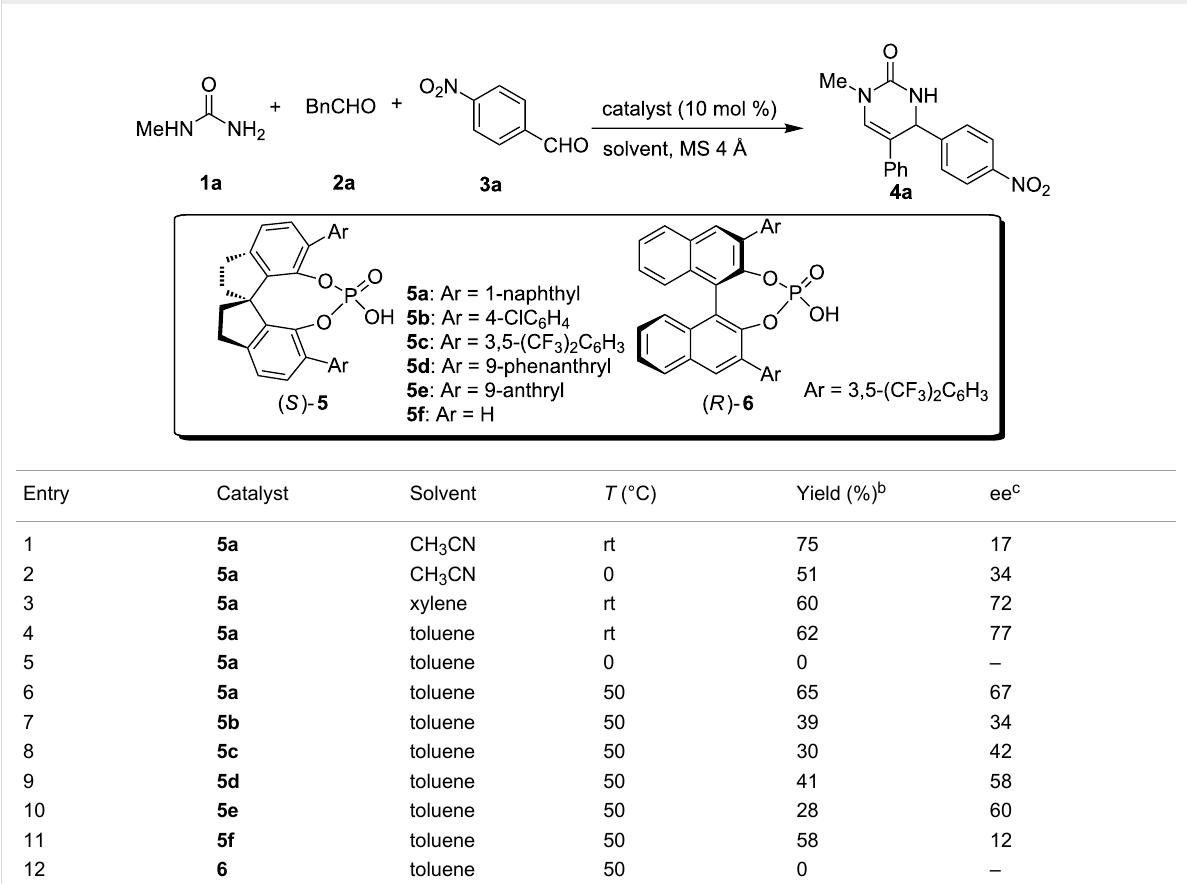
Table 3: Optimization of the asymmetric reaction conditions. a